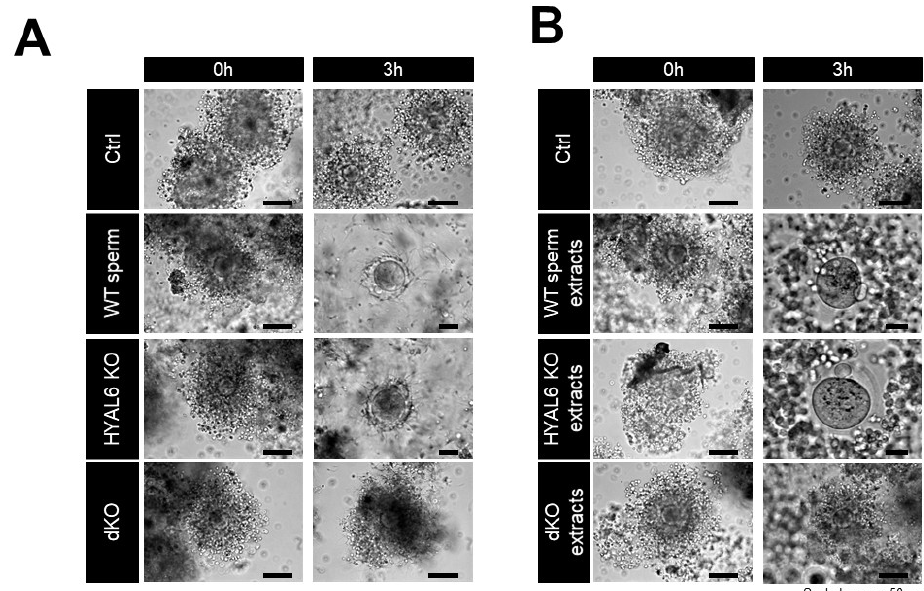
Figure 5. Cumulus cell dispersal by HYAL6 KO sperm and sperm extracts. A. The cumulus–oocyte complexes (COCs) were incubated with KO sperm ( A ) and KO sperm extracts ( B ).